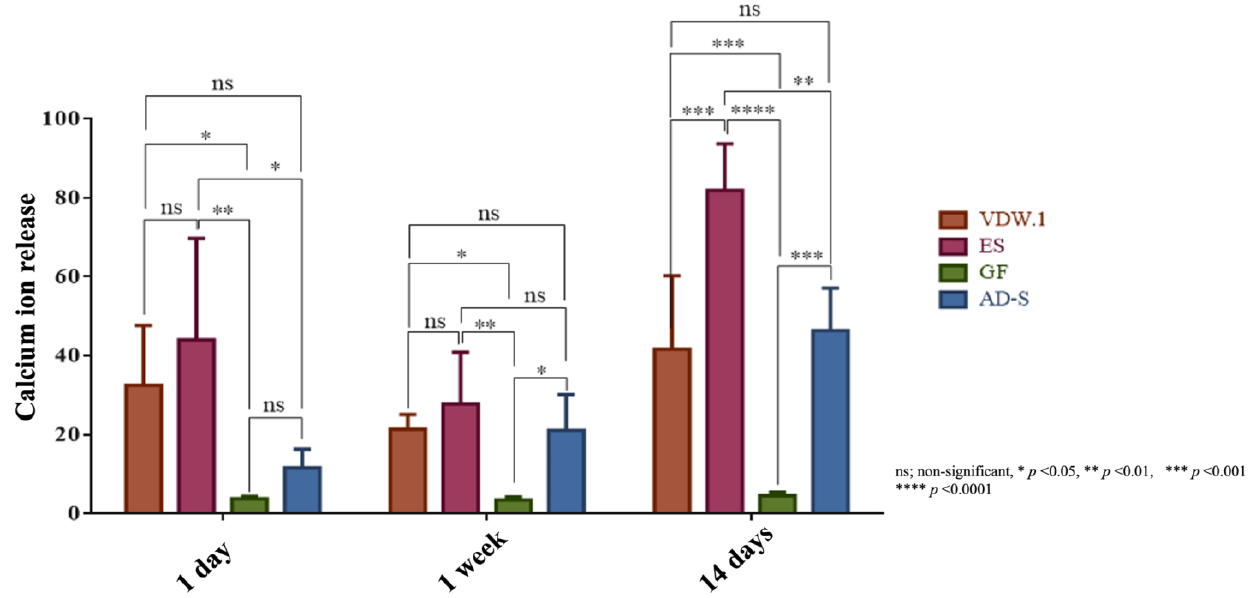
Figure 9. Calcium ion release values of the different sealers, given as means and standard deviations at day 1, after 1 week, and after 14 days. VDW.1—VDW.1Seal, ES—Endosequence BC Sealer HiFlow, GF—GuttaFlow-2, AD-S—ADSeal.